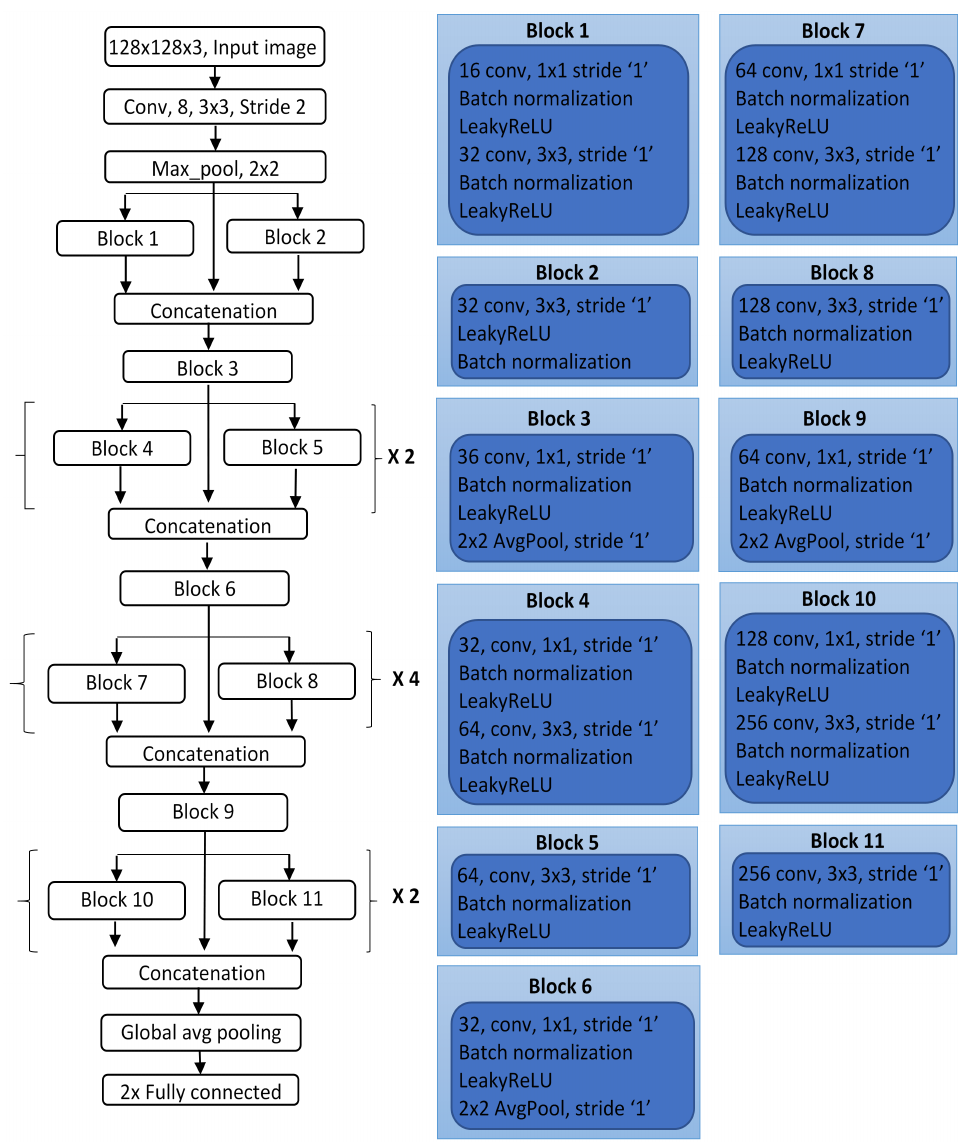
Figure 3. The design of the proposed network,